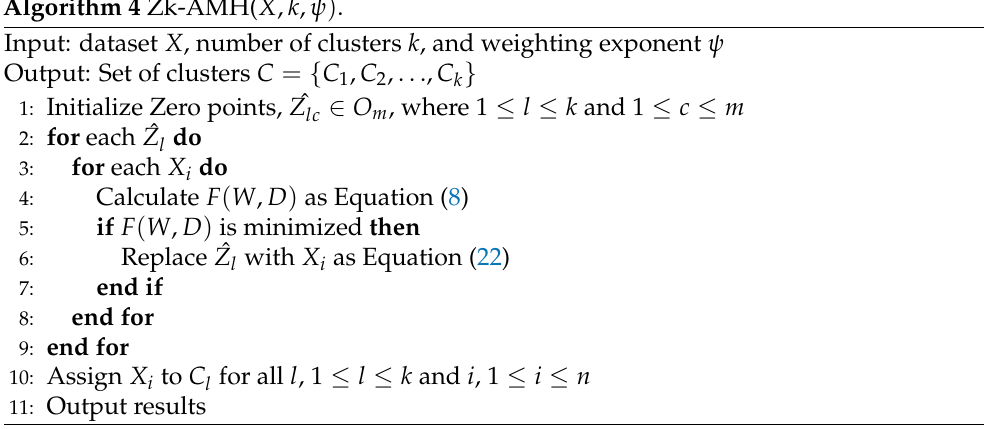
Algorithm 4 Zk-AMH( X , k , ψ ) .